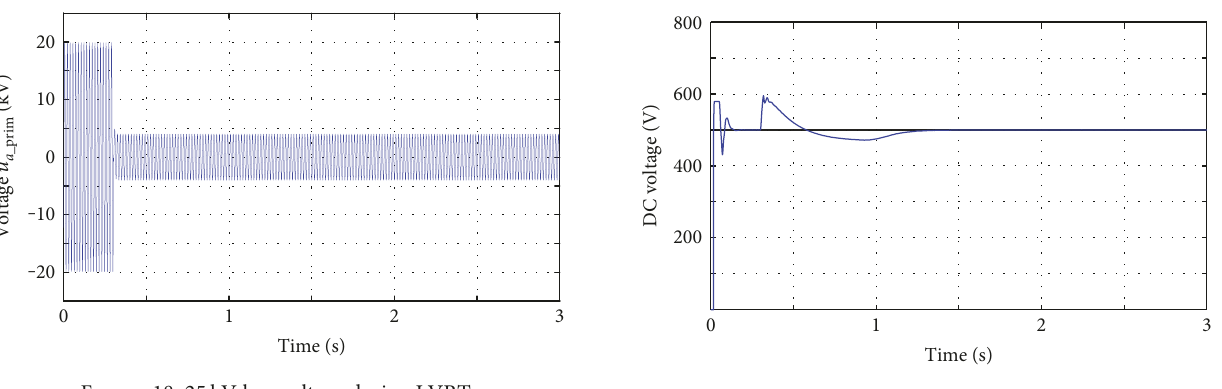
Figure 21: DC link voltage V